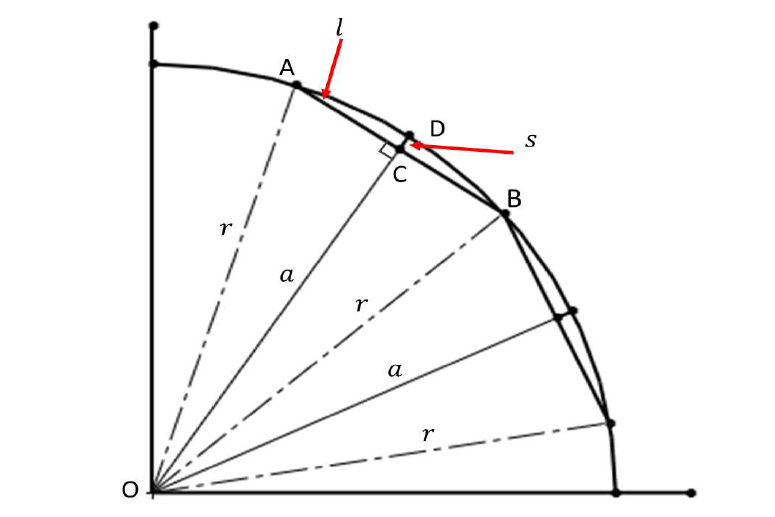
Figure 10. Geometric representation of a sensor carrier inside a concave